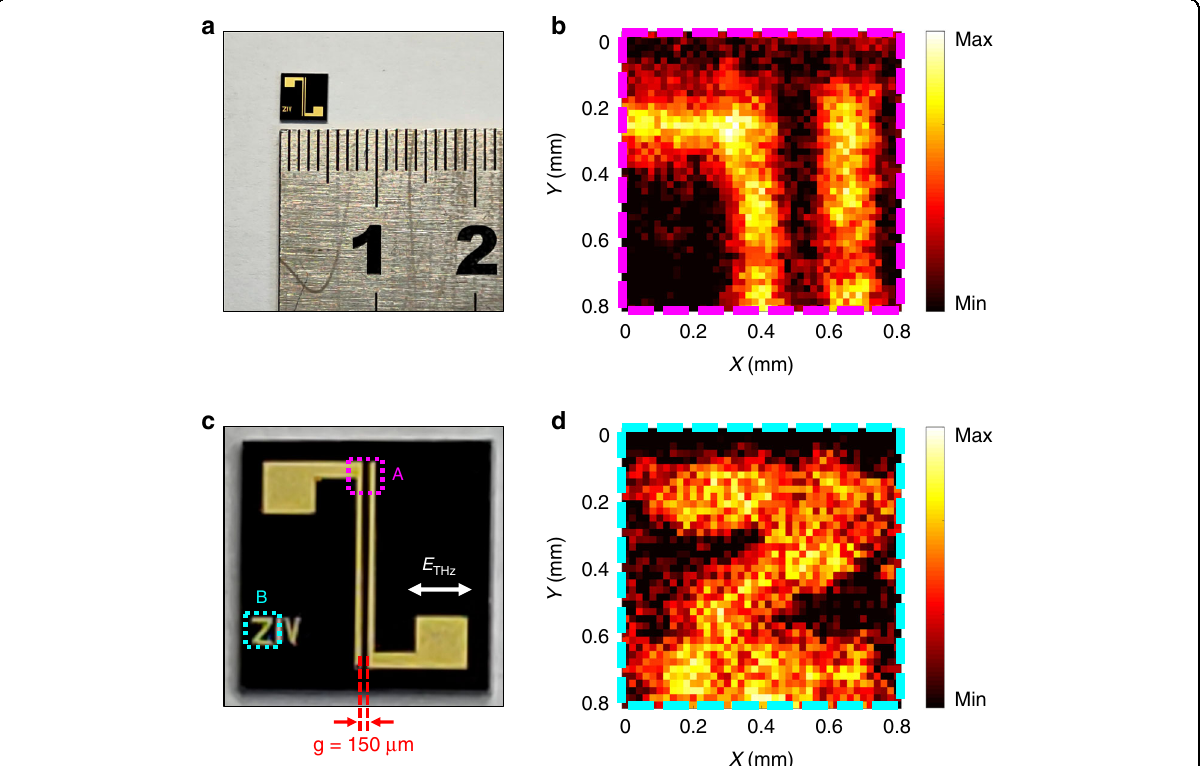
Fig. 4 THz near- fi eld imaging of a semiconductor chip. a Semiconductor chip and a ruler. The chip was a THz antenna. Its electrode material was an AuGeNi-alloy on a semi-insulating gallium arsenide (SI-GaAs) substrate. c Magni fi ed view of the chip. The slit width of the THz antenna was 150 µm, and the THz polarization was perpendicular to the electrodes. Two measurement regions A and B were marked by purple and light-blue dashed boxes. The near- fi eld images of the regions for 1.35 THz are shown in b and d ,